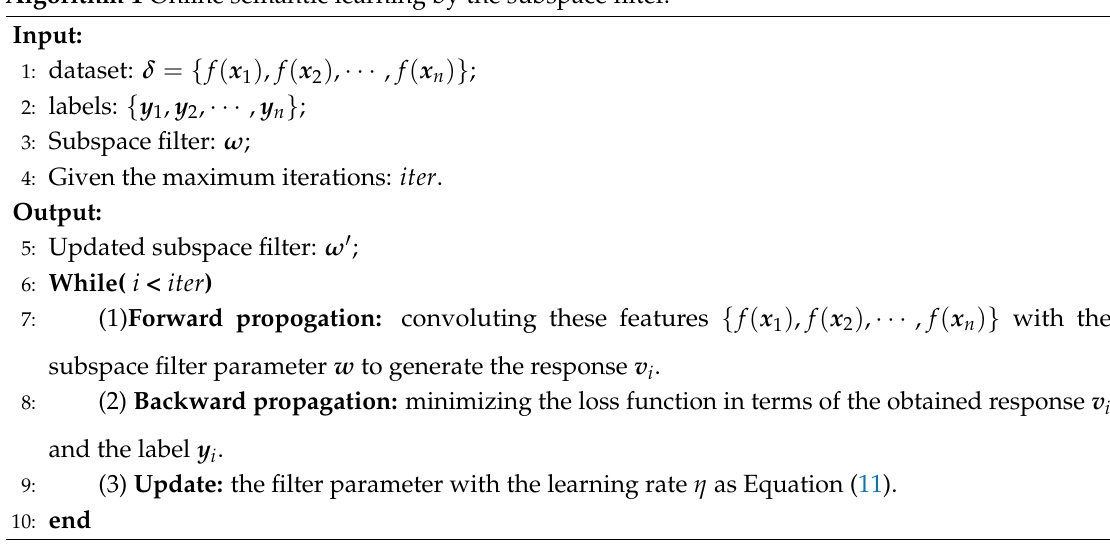
Algorithm 1 Online semantic learning by the subspace